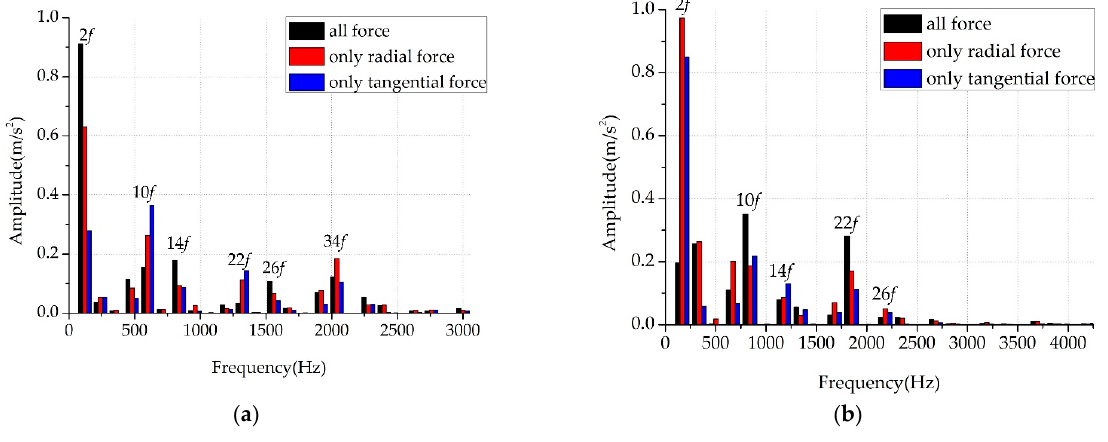
Figure 5. Simulation acceleration spectra at 720 rpm, 26 Nm. ( a ) 10-pole 12-slot PMSM; ( b ) 14-pole 12-slot PMSM.